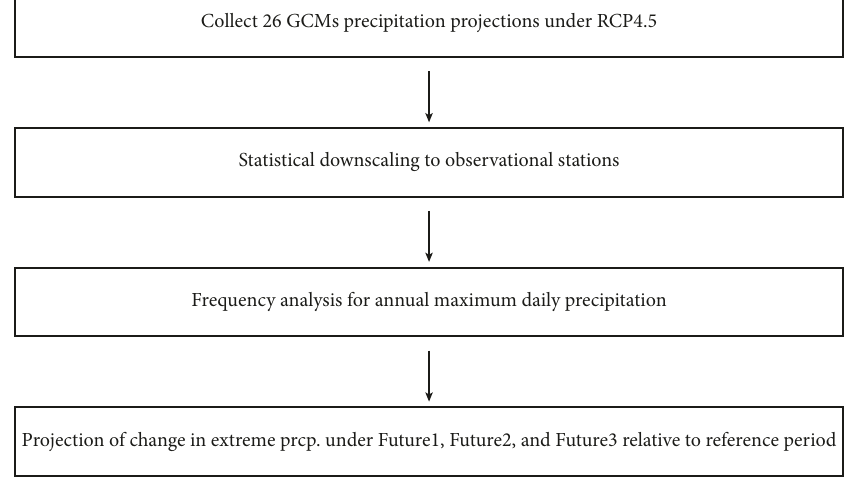
Figure 1: Procedure of this study. Table 1: 26 GCMs of CMIP5 for this